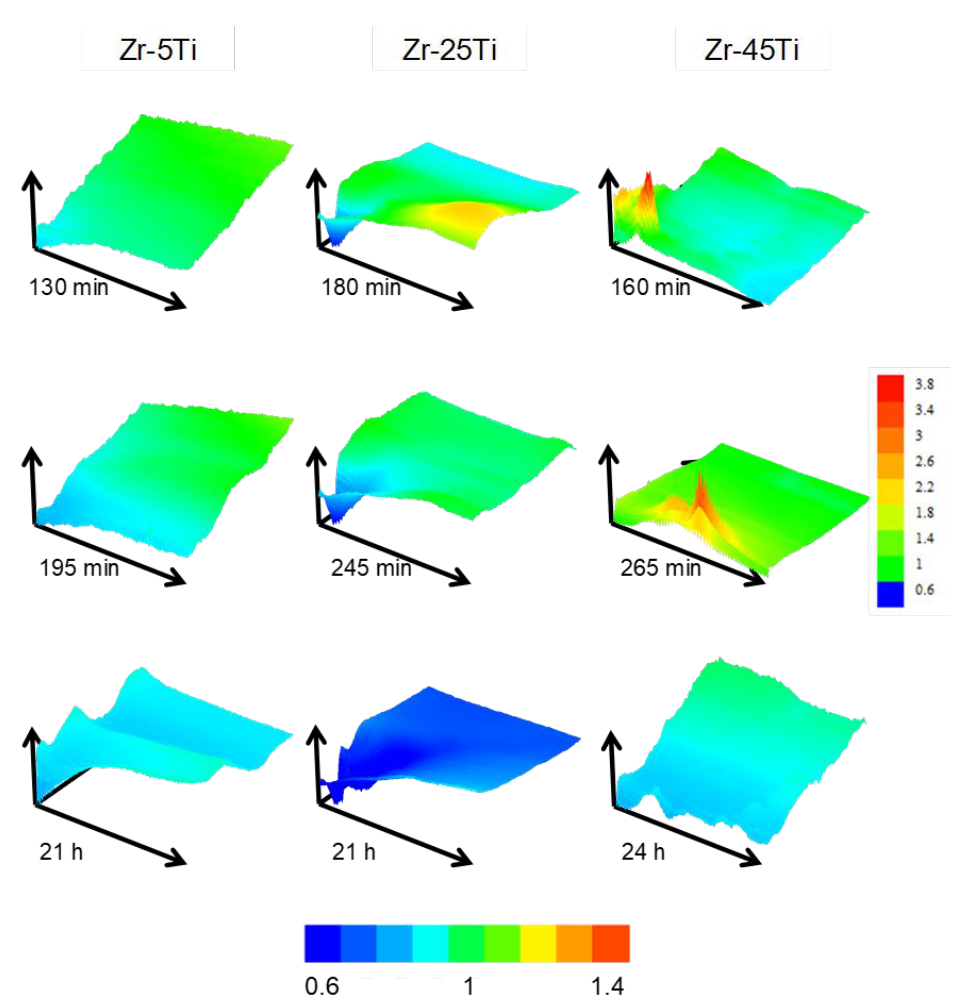
Figure 5. Representative feedback mode 2-D scans of 500 × 500 µm 2 dimension on oxidized binary Zr-Ti alloys immersed in acidified Ringer’s solution at 37 °C. Images in a column were obtained over the same sample and area, indicated at the top of the figure. Time immersion is given below each scan. The color scale gives the normalized current in all scans except for the scan measured on Zr-45Ti after 265 min, which is plotted with its own color scale.